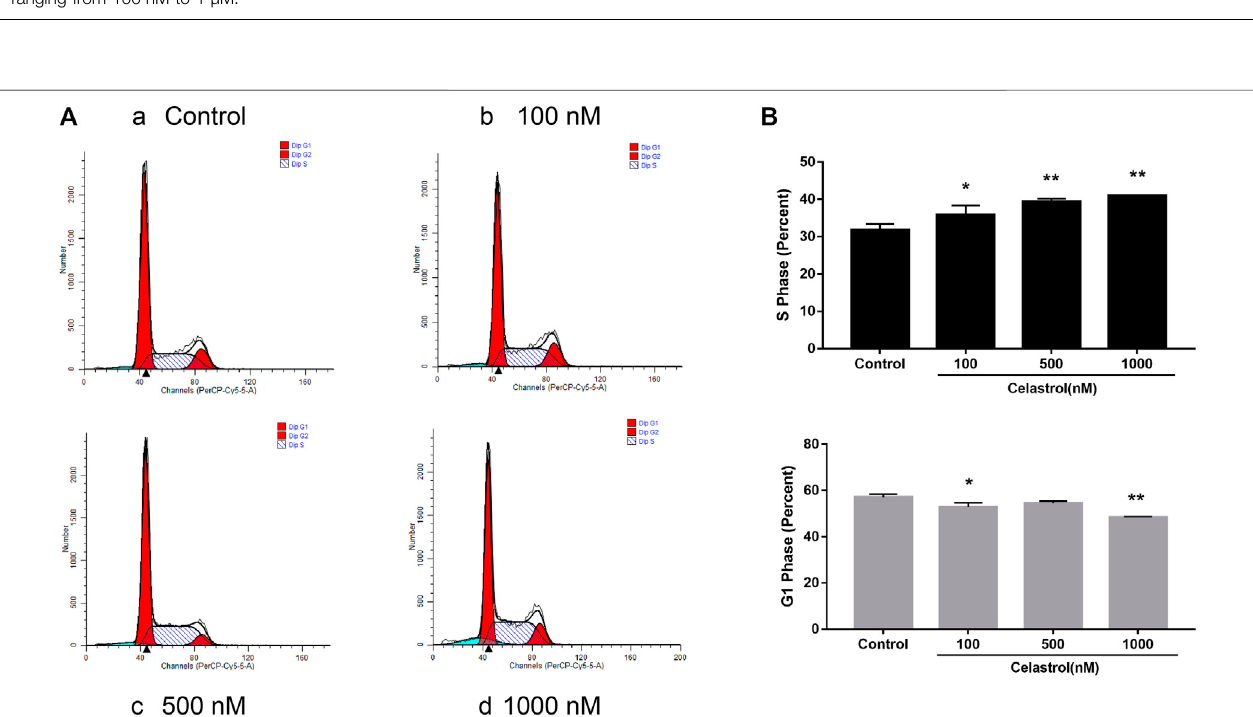
FIGURE9 | Effectofcelastrol on cellcycle in ovarian cancer. Aftertreatmentwithcelastrol, the proportion ofcells in Sphase wasincreased compared withcontrol group (from 31.73 ± 1.6% to 40.98 ± 0.02%), while the proportion of G1 phase cells were reduced (from 57.03 ± 1.34% to 48.59 ± 0.19%). Compared with the control group, * p < 0.05, ** p < 0.01.